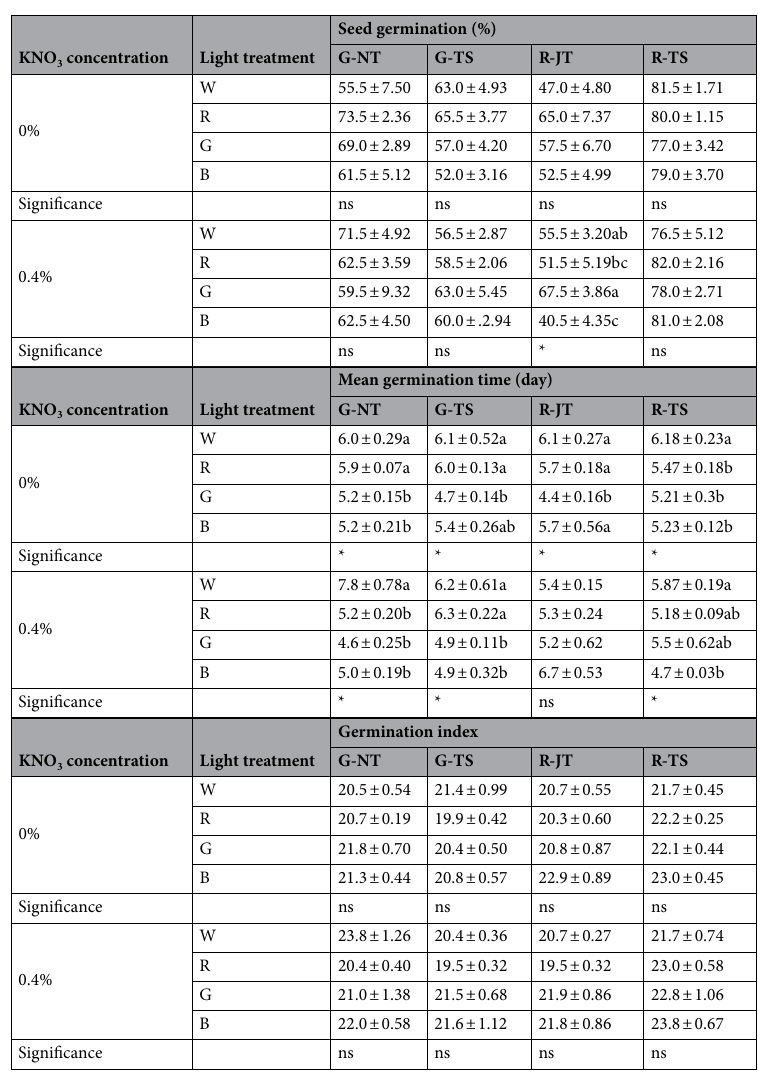
Table 3. Final seed germination percentage (GP) and mean emergence time (MGT) and germination index (GI) before transplanting at 15 days after sowing of four holy basil varieties by seed priming with KNO 3 , under different LED light treatments; white (W), monochromic red (R), green (G) and blue (B) in the PFAL system. Data are mean values ± SE (n = 4) with four fifty seeds in a replication. Different letters in the same column indicate significant difference at p < 0.05. * indicates significant difference. “ns” indicates no significant